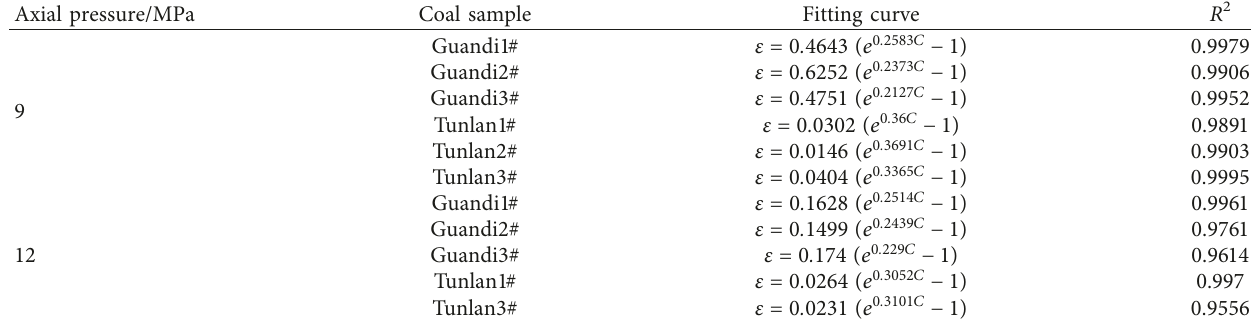
Table 1: Fitting results of coal strain and gas